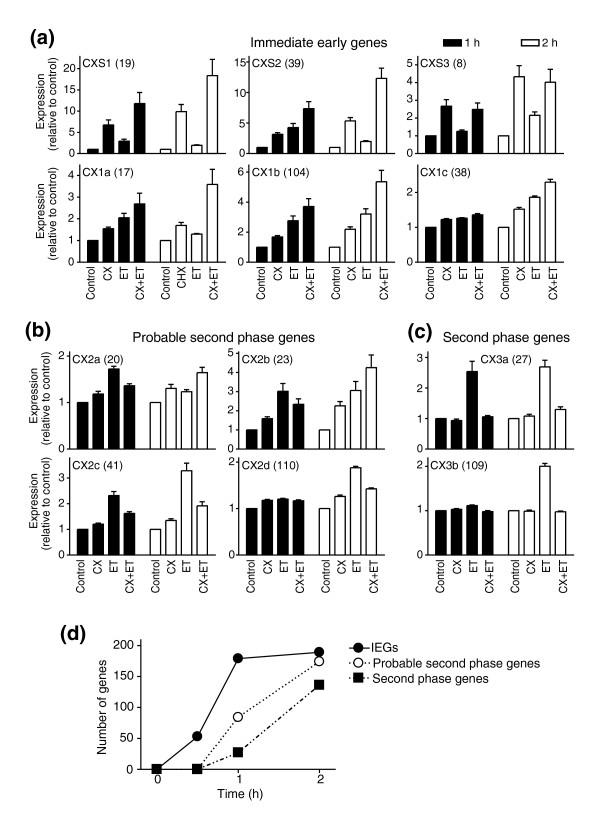
Identification of immediate early and second phase RNAs with increased expression in response to ET-1. Cardiomyocytes were unstimulated (Control), exposed to cycloheximide (CX) alone, or to ET-1 (ET) in the absence or presence of cycloheximide for 1 h (solid bars) or 2 h (open bars). (a) RNAs in CXS1, CXS2 and CXS3 (whose induction by ET-1 was further increased by cycloheximide), and CX1a, CX1b and CX1c (whose induction was not inhibited by cycloheximide) were classified as immediate early gene RNAs. (b) CX2a, CX2b, CX2c and CX2d RNAs showed partial inhibition of the response to ET-1 at 1 h by cycloheximide and are probably second phase RNAs. (c) CX3a and CX3b RNAs were clearly second phase RNAs with >80% inhibition of the response to ET-1 by cycloheximide. The numbers of transcripts in each cluster are shown in parentheses. Statistical significance (repeated measures one-way ANOVA with Tukey post-test) p < 0.05 for Control versus ET-1 (2 h; all clusters), Control versus ET-1 (1 h; all clusters except CXS3, CX1c, CX2d and CX3b), Control versus CX (1 or 2 h; all clusters in (a)), ET-1 (2 h) versus CX+ET-1 (2 h) (all clusters except CX2a/b), ET-1 (1 h) versus CX+ET-1 (1 h) (all clusters except CX1b/c, CX2d and CX3b). (a-c) Results are means ± SEM for three independent sets of samples. (d) Numbers of IEG versus second phase genes upregulated in cardiomyocytes in response to ET-1 over the first 2 h.